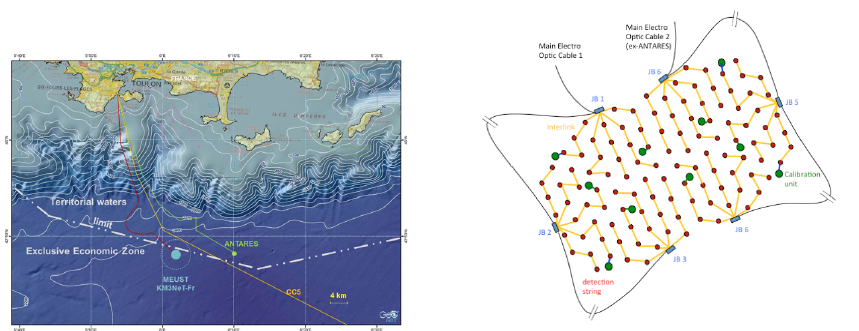
Figure 2. Left: map of the Mediterranean Sea south of Toulon, France. The location of the KM3NeT-France and ANTARES installations are indicated. Right: layout of the ORCA detector, depicting the 115 DUs, cables and connection devices of the full